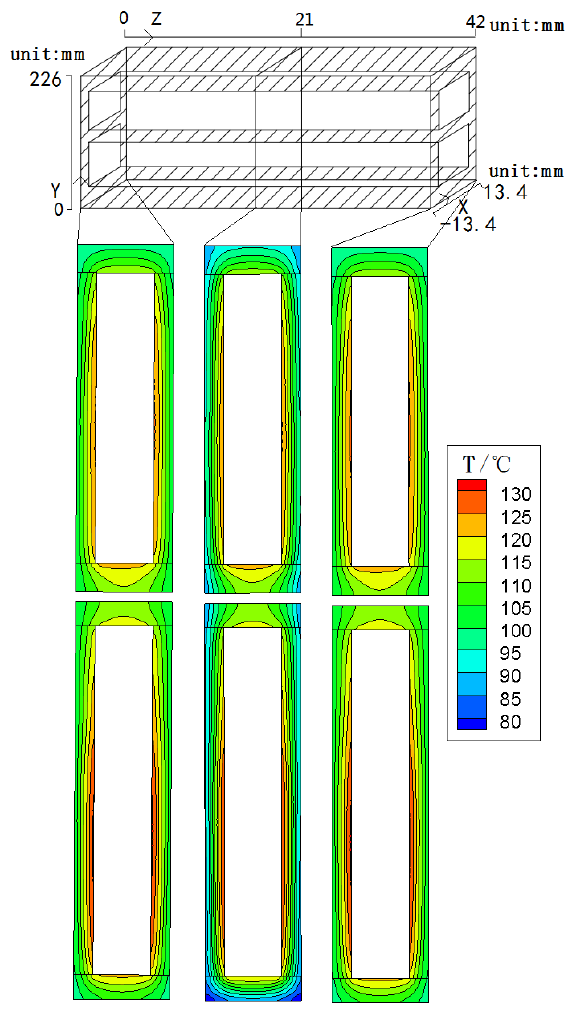
Figure 9. The main insulation temperature distribution along the circumferential–radial section under normal operation.